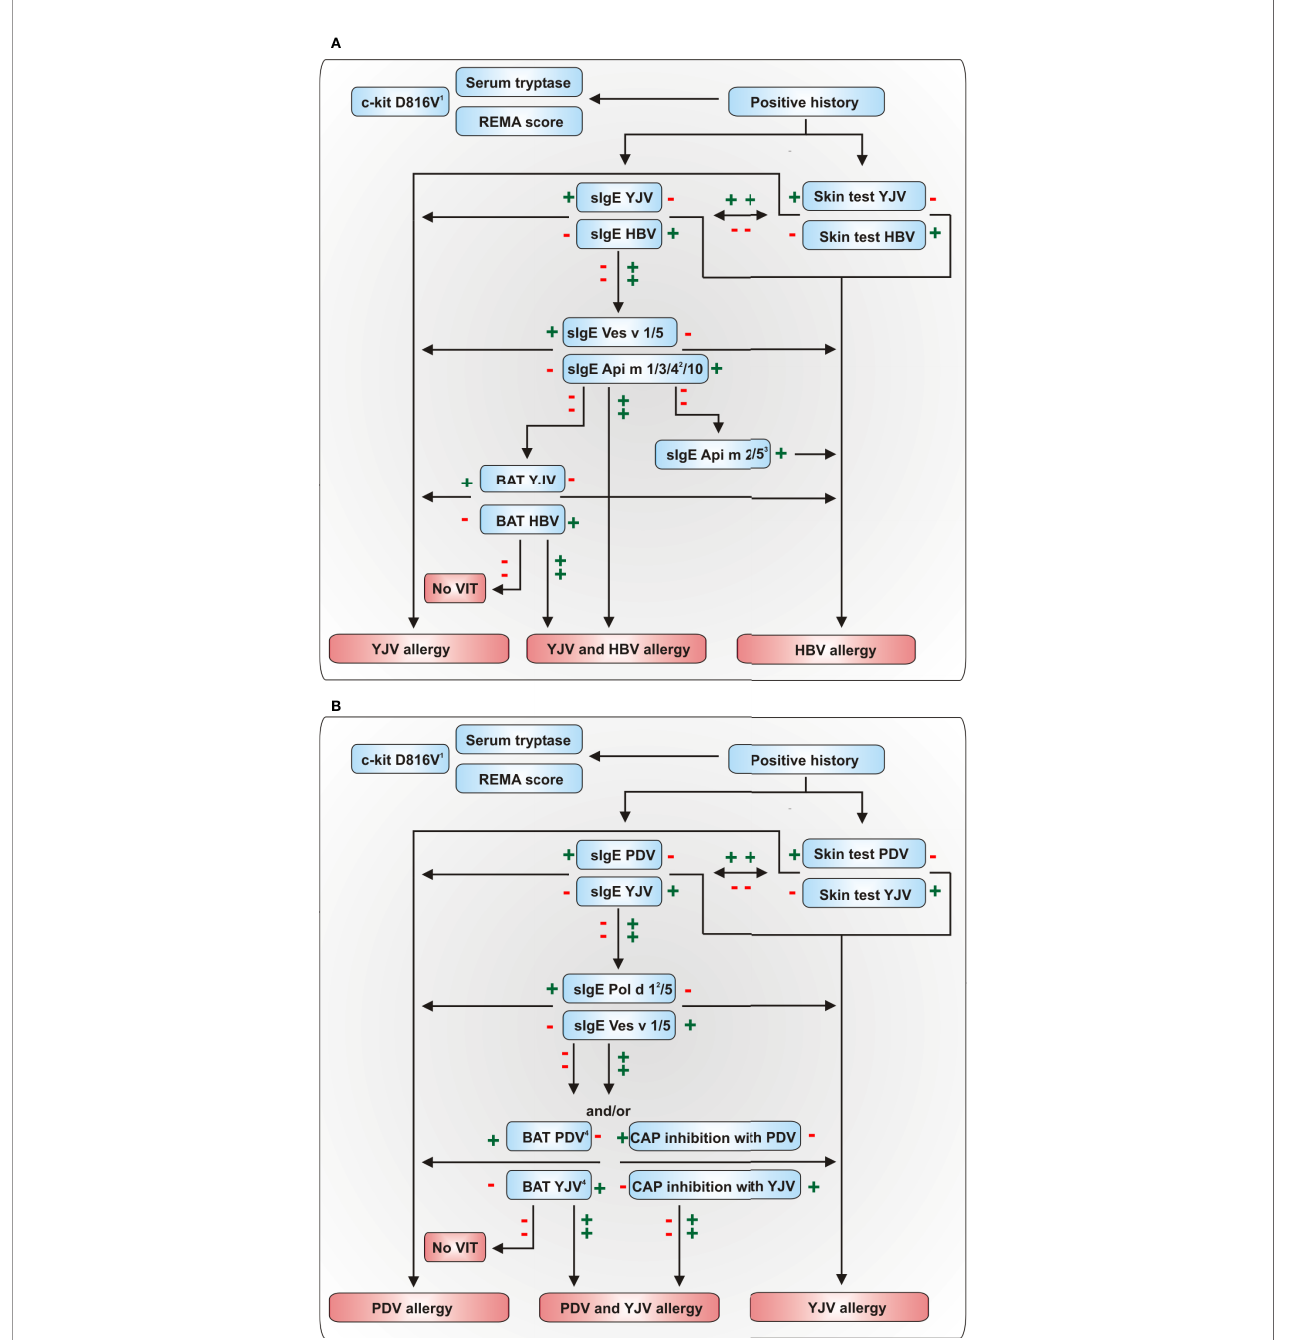
FIGURE 3 | Diagnostic algorithms for the discrimination of (A) HBV and YJV allergy and (B) YJV and PDV allergy. The diagnostic algorithm presented in (A) can also be used to discriminate between HBV and PDV allergy using the Polistes dominula homologues of Ves v 1 and Ves v 5, Pol d 1 and Pol d 5, respectively. A plus indicates a positive and a minus a negative test result. 1 In the majority of cases, positive PCR results proving the presence of the c-kit D816V mutation in peripheral blood mononuclear cells can con fi rm systemic mastocytosis (121). 2 These allergens are only available for selected multiplex sIgE platforms. 3 The HBV allergens Api m 2 and Api m 5 show potential cross-reactivity to not commercially available homologous allergens of YJV and PDV so that a positive test result does not necessarily preclude YJV or PDV allergy. 4 BAT proved to be an effective tool for the assessment of double-positivity in HBV and YJV allergy (122). However, currently, no studies have analyzed its usefulness for the discrimination of PDV and YJV allergy. BAT, basophil activation test; HBV, honeybee venom; PDV, Polistes dominula venom; REMA score, score of the Spanish Network on Mastocytosis for predicting mast cell clonality and systemic mastocytosis in patients who experience anaphylaxis without cutaneous mastocytosis; VIT, venom-speci fi c immunotherapy; YJV, yellow jacket